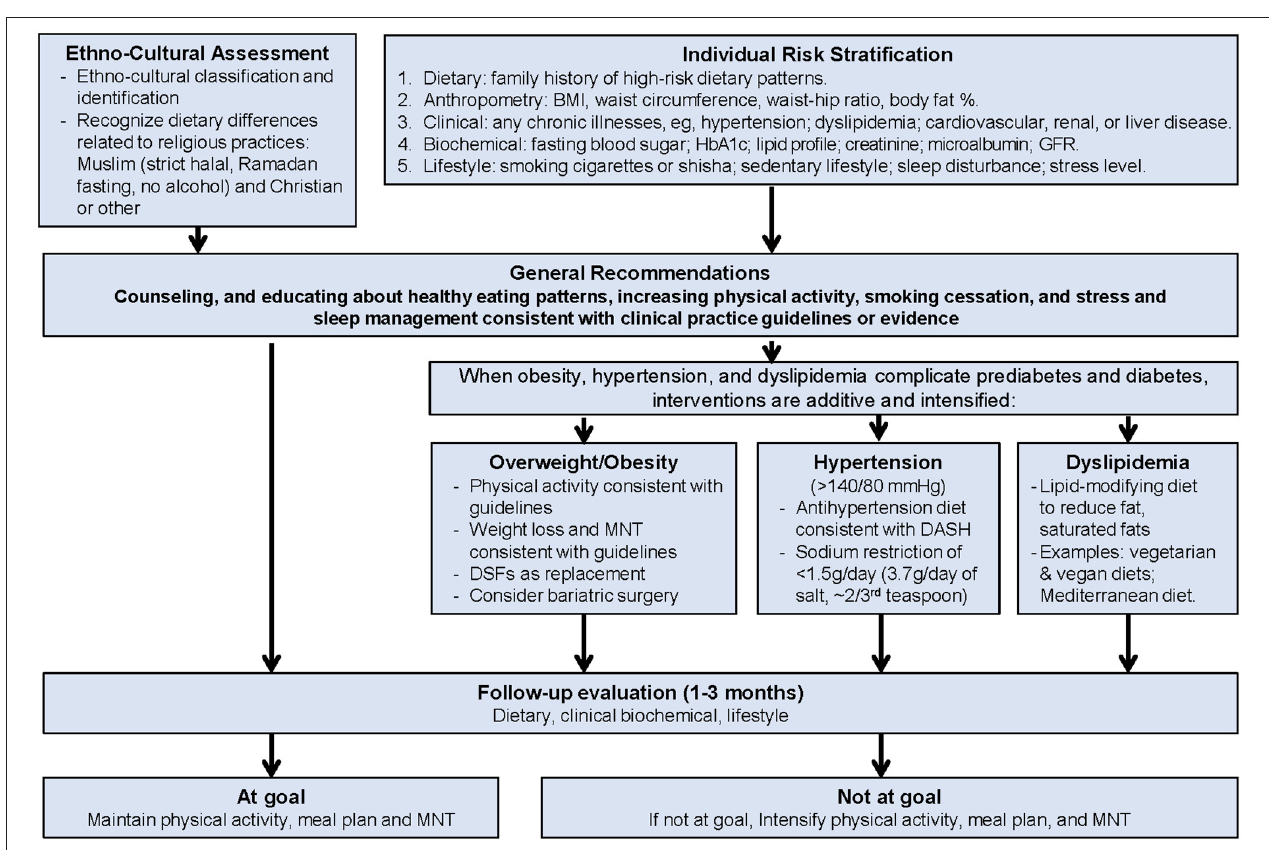
FIGURE 1 | Middle East transcultural diabetes nutrition algorithm for prediabetes and type 2 diabetes. Figure adapted for the ME from Mechanick et al. (15).